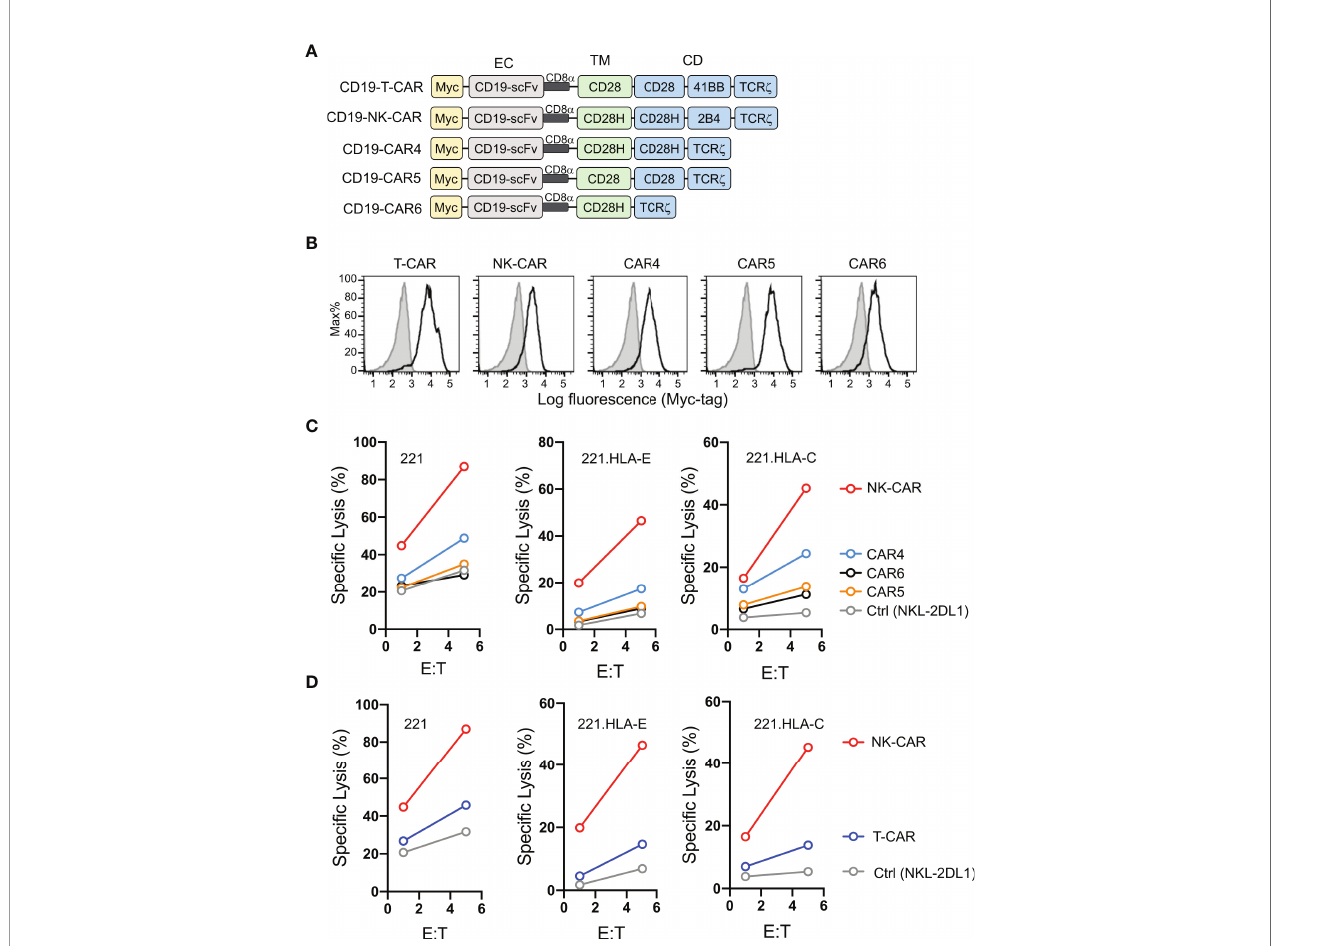
FIGURE 2 | Lysis of CD19 + HLA-I + tumor cells by NK cells that express CD19.CARs. (A) Schematic diagram of CAR constructs using anti-CD19 scFv with a N- terminal myc-tag as extracellular domain and the indicated combinations of signaling domains. (B) Histograms showing expression of CAR constructs in NKL.2DL1 cells. (C) Killing assays comparing lysis of target cells by the indicated CAR-expressing NKL.2DL1 cells. The HLA-A, HLA-B and HLA-C negative lymphoblastoid cell line 221, or 221 cells transfected with HLA-E or HLA-Cw15 were used as target cells (n=3). (D) Comparing target-cell lysis by NKL.2DL1 cells expressing NK-CAR or T-CAR (n=3). Same target cells were used as in (C)